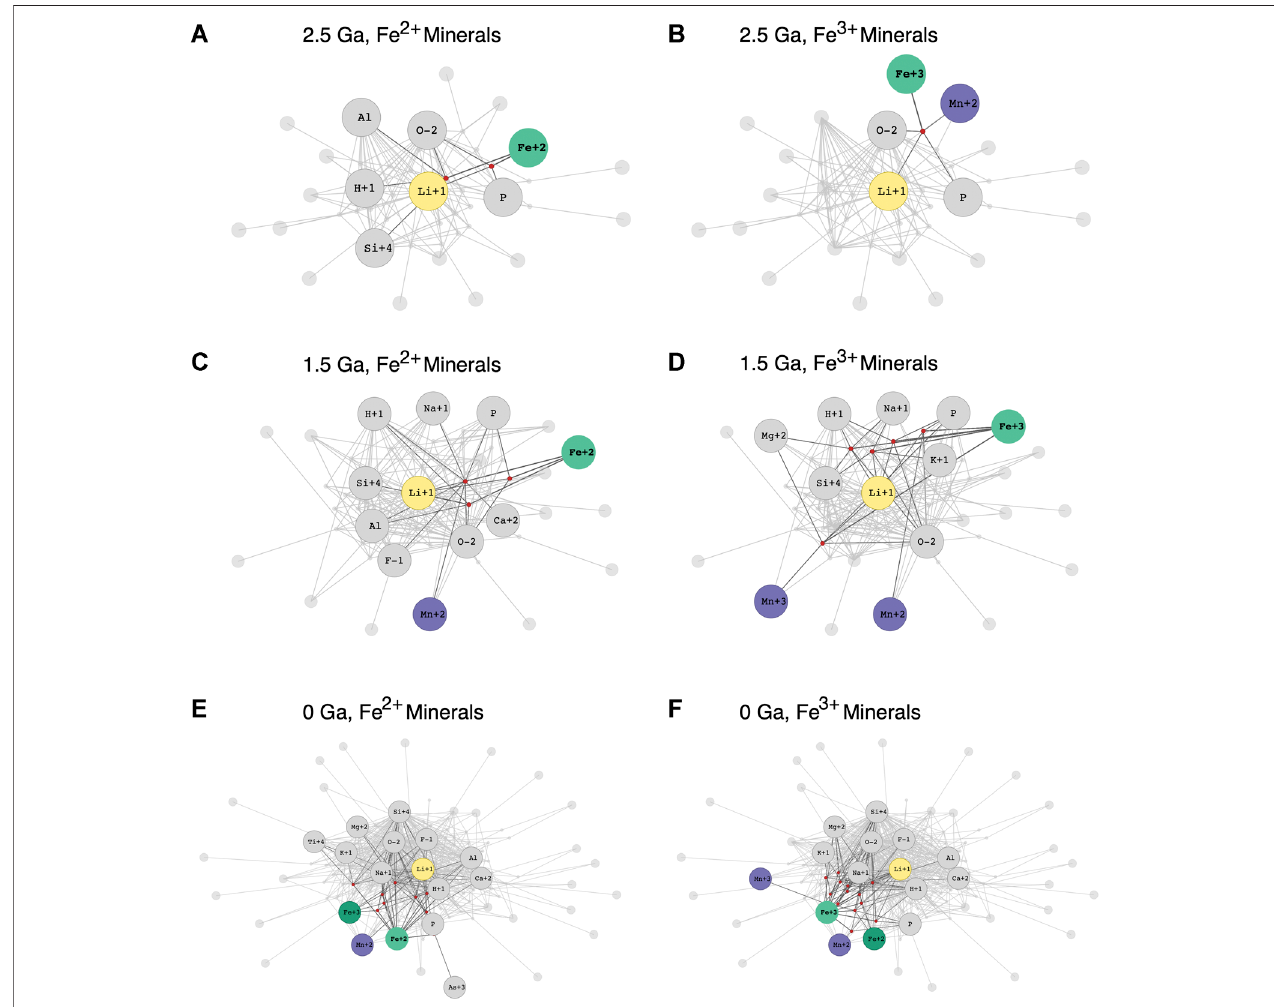
FIGURE 2 | Lithium mineral-chemistry network with element nodes separated by redox states over time. In all panels, Li is highlighted in yellow, and Iron (Fe) and manganese(Mn)nodesatdifferentredoxstatesareshowningreenandpurple,respectively.Allotherelementnodesareshowningray,allmineralnodesthatcontainthe highlighted elements are shown in red, and minerals that do not contain the highlighted elements are shown in gray. In each network image, only second-degree connections from the emphasized Fe node (Fe 2+ in panels A , C , and E and Fe 3+ in panels B , D , and F ) are labeled. (A) The Li mineral-chemistry network for all minerals with oldest-known formation dates ≥ 2.5 Ga, with Li-minerals containing Fe 2+ emphasized. (B) The Li mineral-chemistry network for all minerals with oldest- known formation dates ≥ 2.5 Ga, with Li-minerals containing Fe 3+ emphasized. (C) The Li mineral-chemistry network for all minerals with oldest-known formation dates ≥ 1.5 Ga,withLi-mineralscontainingFe 2+ emphasized. (D) TheLimineral-chemistrynetworkforallmineralswitholdest-knownformationdates ≥ 1.5 Ga,withLi-minerals containing Fe 3+ emphasized. (E) The full Li mineral-chemistry network, with Li-minerals containing Fe 2+ emphasized. (F) The full Li mineral-chemistry network, with Li- minerals containing Fe 3+